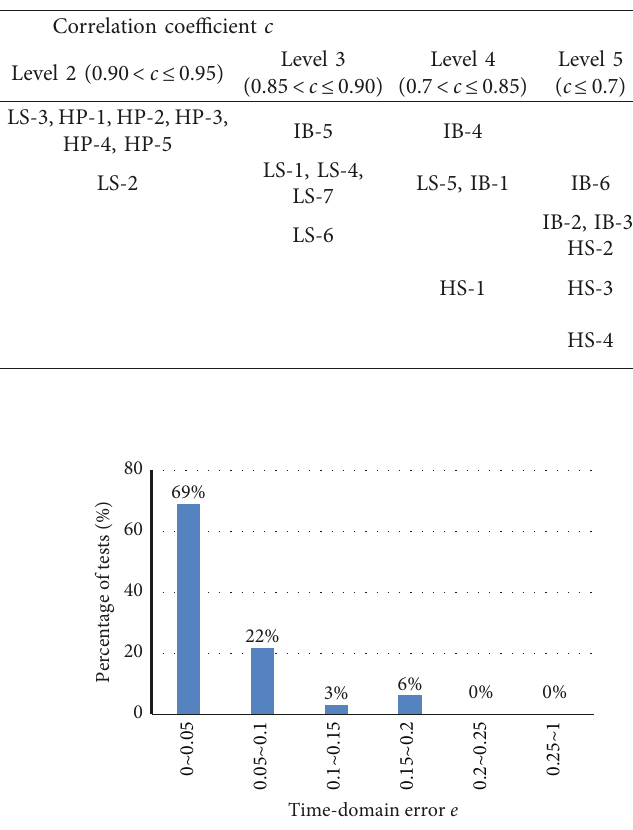
Figure 30: Root-mean-square error distribution diagram of dif- ferent test cases.